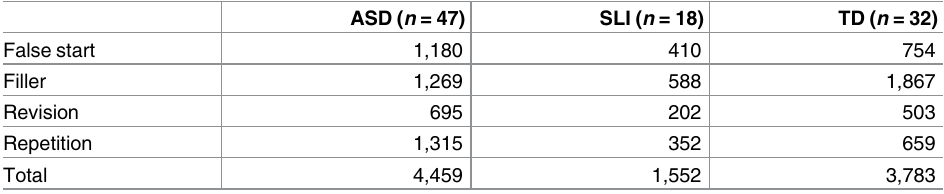
Table 3. Number of disfluencies by type and